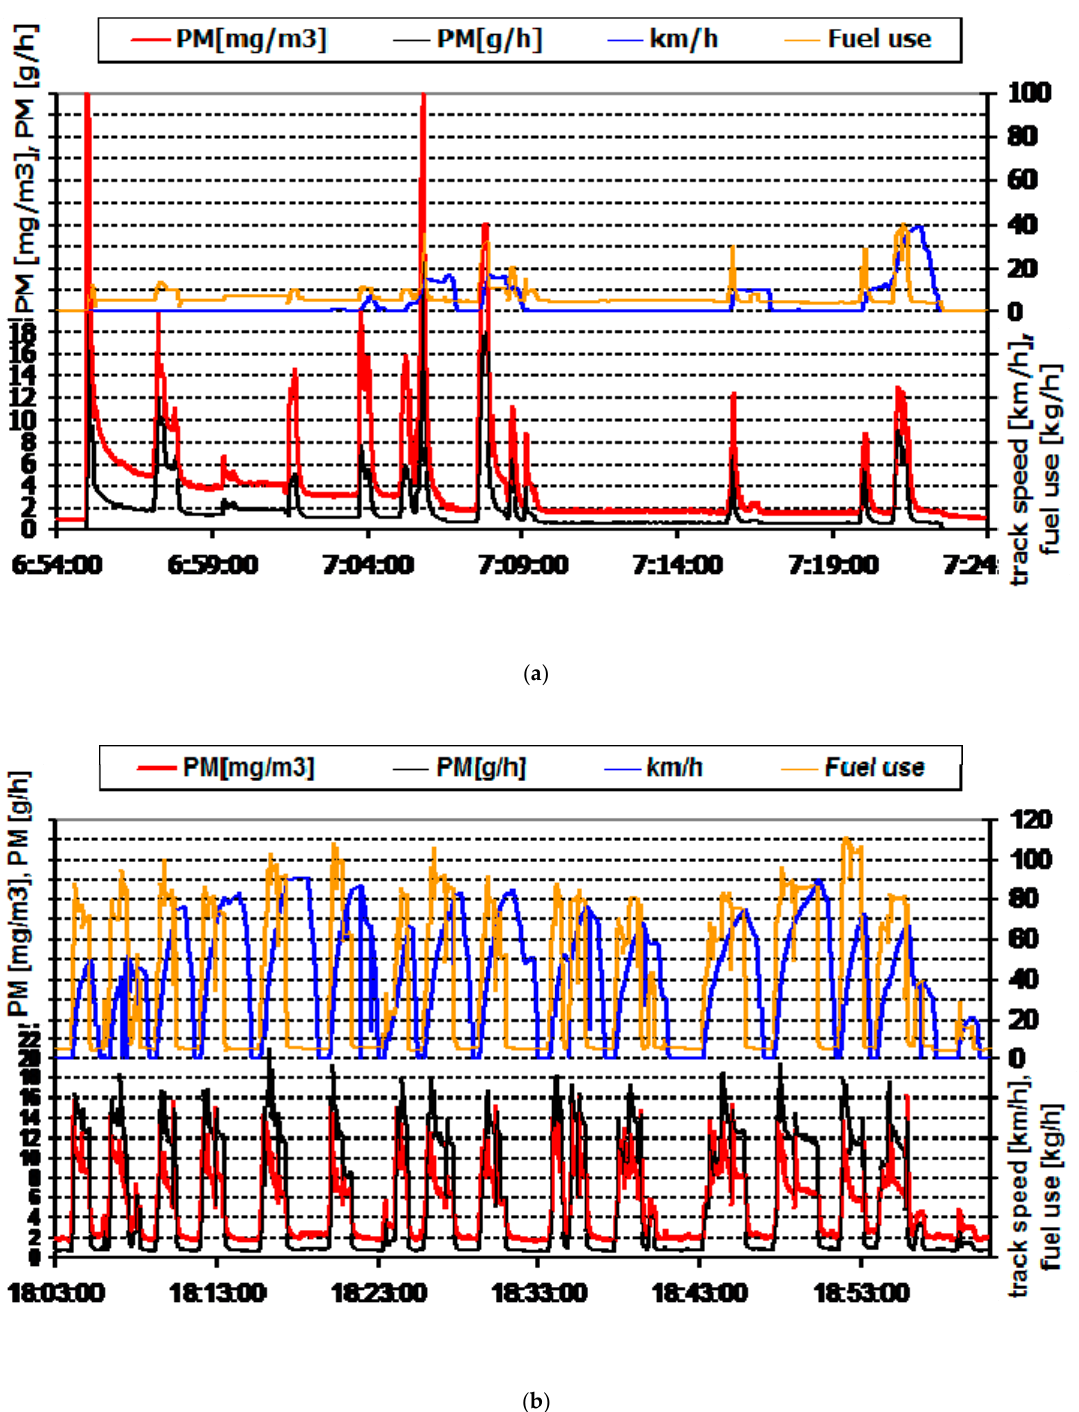
Figure 13. Track speed, fuel consumption, and particulate matter emissions from an 854 series railcar, showing: ( a ) cold start and switching at the depot; and ( b ) local service. PM and NO x emission rates as a function of the instantaneous fuel consumption are plotted in Figure 14. The slope of the graphs represents fuel-specific emissions (in grams per kg fuel). In addition, as engine power is nearly a linear function (with a non-zero offset) of the fuel consumption [46], brake-specific emissions in g/kWh may be inferred from the slope. Unfortunately, the slope is not linear and is not uniform. Higher PM is apparent during cold engine operation and during transients, but also, higher engine loads are characterized by — compared to